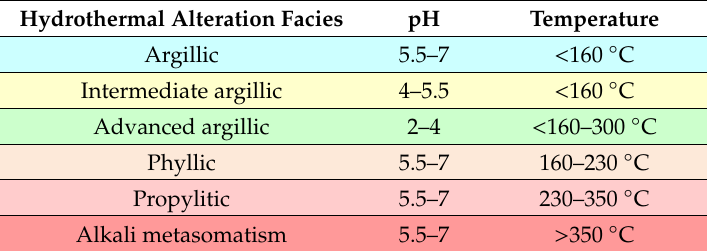
Table 1. Main types of hydrothermal alteration facies and their indicative T and pH conditions of